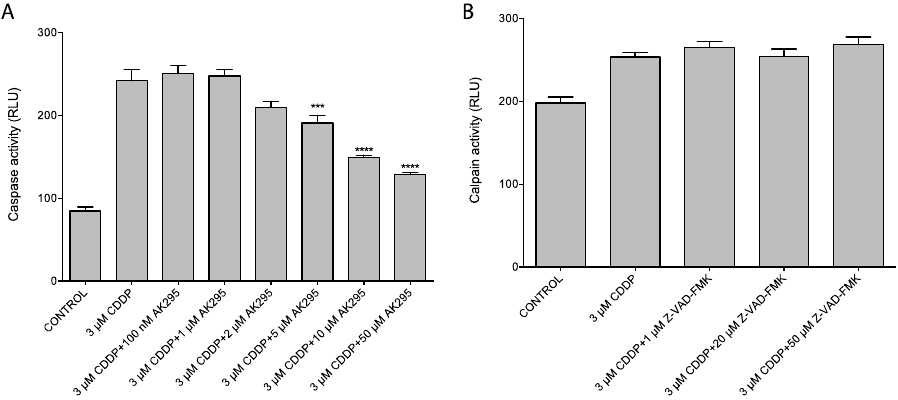
Figure 3. Calpain inhibitor AK295, inhibited CDDP-induced caspase 3/7 activation ( A ) suggesting that caspase activity is downstream of calpain activation (RLU: relative light units). In contrast, pan-caspase inhibitor Z-VAD-FMK did not have any effect on calpain activity ( B ) (n = 6, ** p < 0.01, **** p < 0.0001, one way ANOVA with multiple comparisons, error bars denote SD).